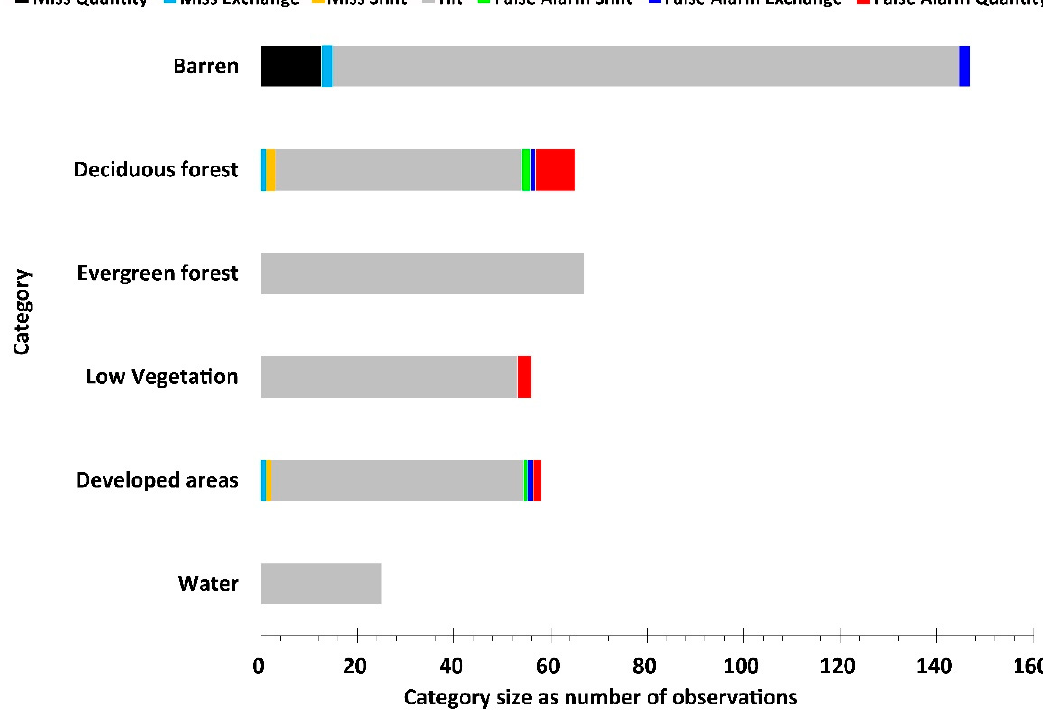
Figure 4. Category size errors for 1976. Miss and false alarm as number of observations.